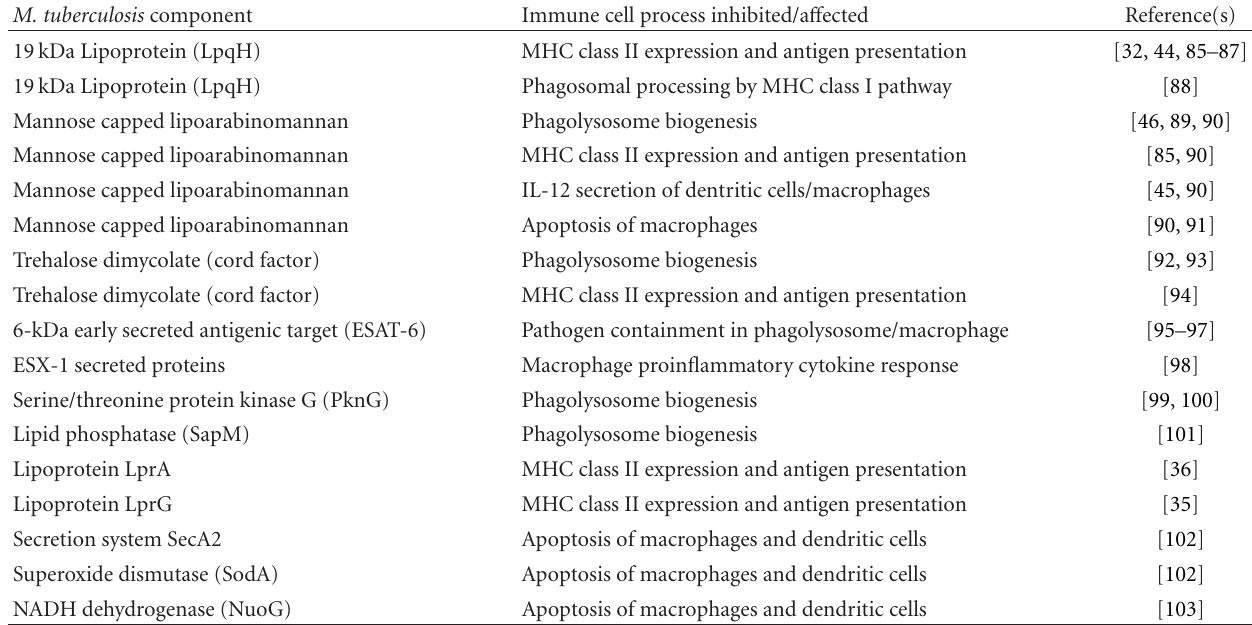
Table 1: Some important M. tuberculosis factors that modulate the innate immune response and promote persistence of the pathogen leading to latent tuberculosis